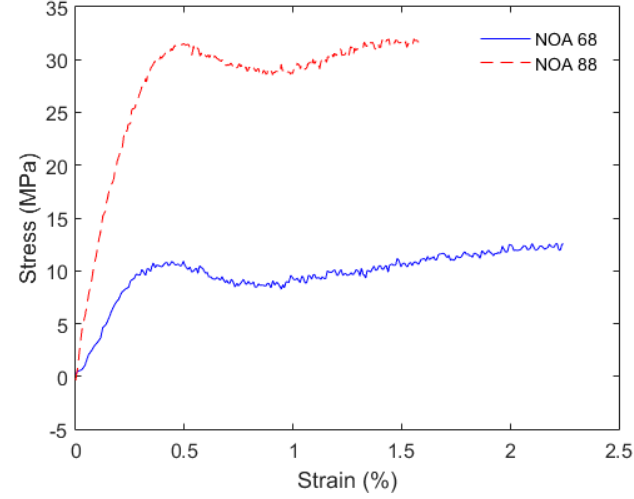
Figure 5. Stress-strain curves of the tensile tests performed with the coated samples .